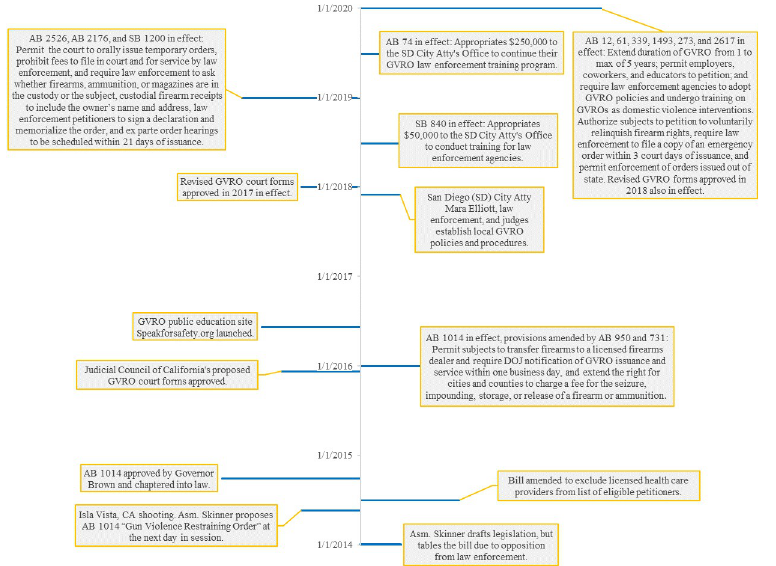
Fig 1. Timeline of the GVRO law and implementation